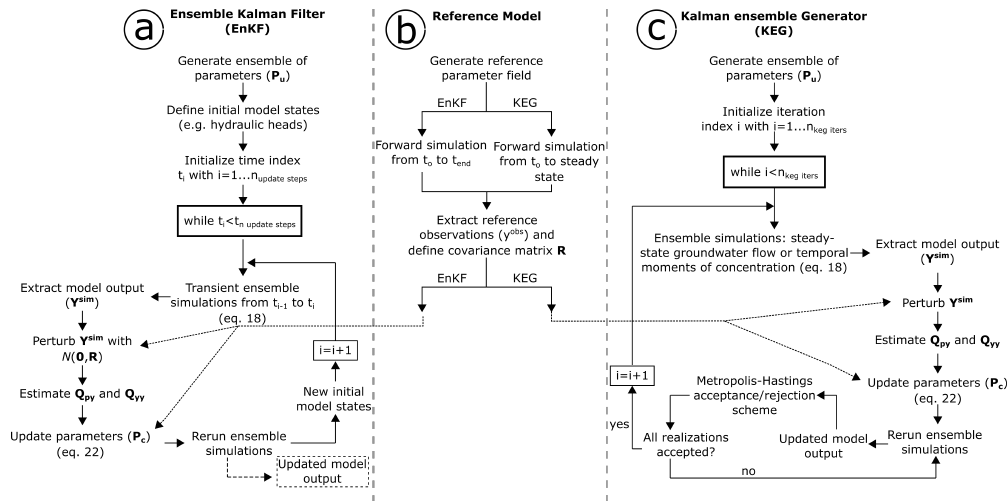
Figure 1. General description of the forecast/update schemes of the Ensemble Kalman Filter ( column a ) and the Kalman Ensemble Generator ( column c ). ( column b ) refers to the steps for creating a reference model to obtain synthetic data for both ensemble Kalman-based